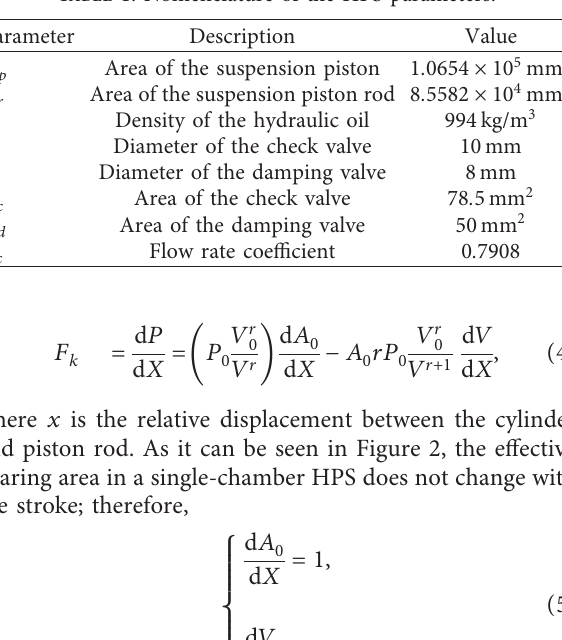
Figure 2: Structure diagram of the HPS. Table 1: Nomenclature of the HPS